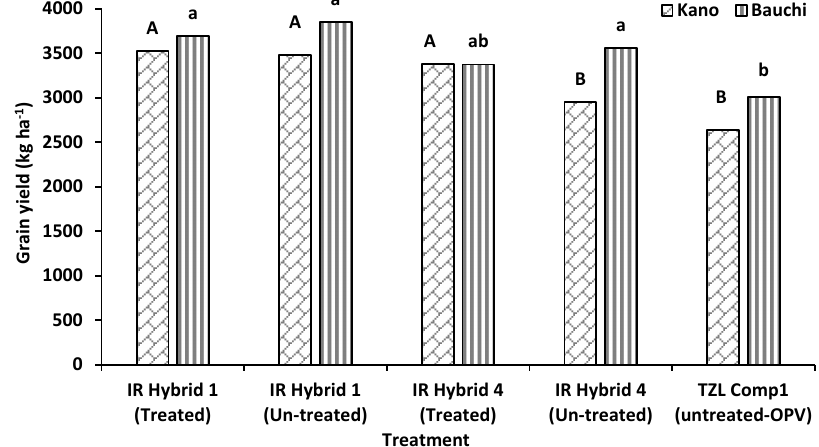
Figure 5. E ff ect of seed coating of IR maize hybrid with imazapyr on grain yield in farmers’ fields in Kano and Bauchi 2014.